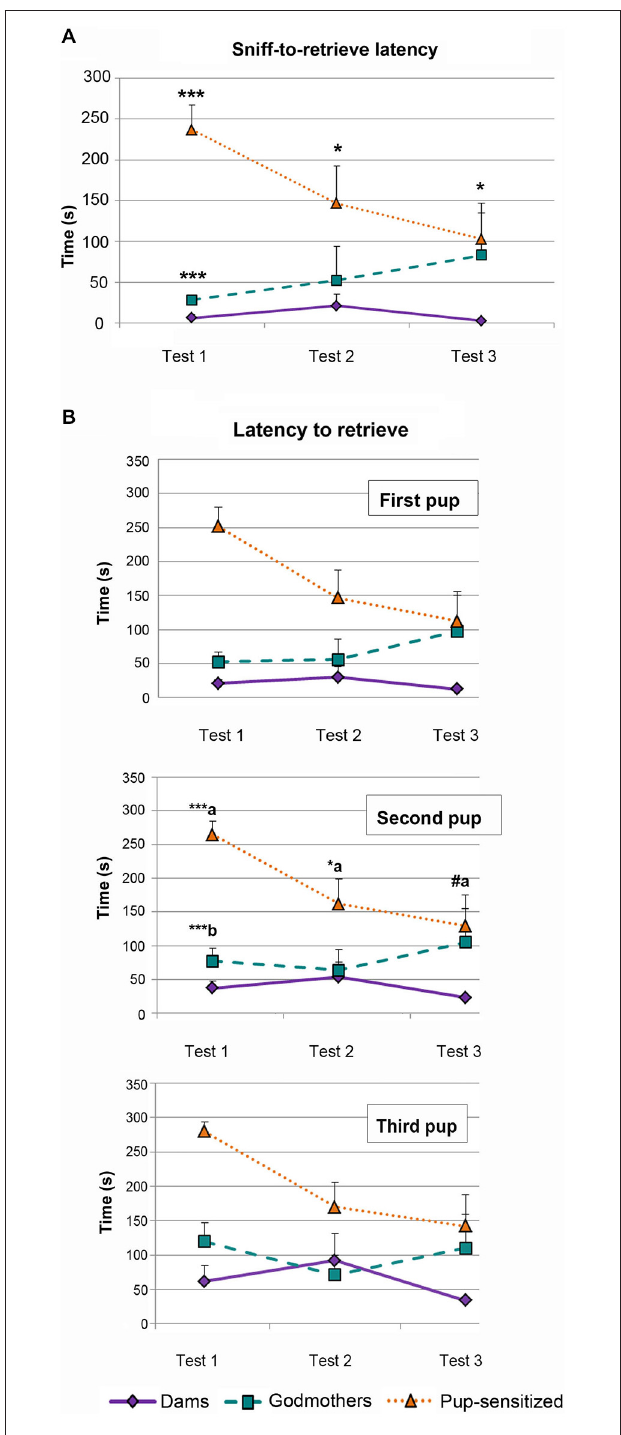
FIGURE 2 | Behavioral measures of the pup retrieval test. (A) Time difference between first sniff and retrieval the first pup. Time difference spent by dams, godmothers, and pup-sensitized females between the first sniffing of a pup and the first pup retrieval in each test day. ANOVA of repeated measurements indicated that dams initiated faster pup retrieval after sniffing the first pup than pup-sensitized females across the 3 days of testing. Godmothers were slower than dams only on the first day. Data are